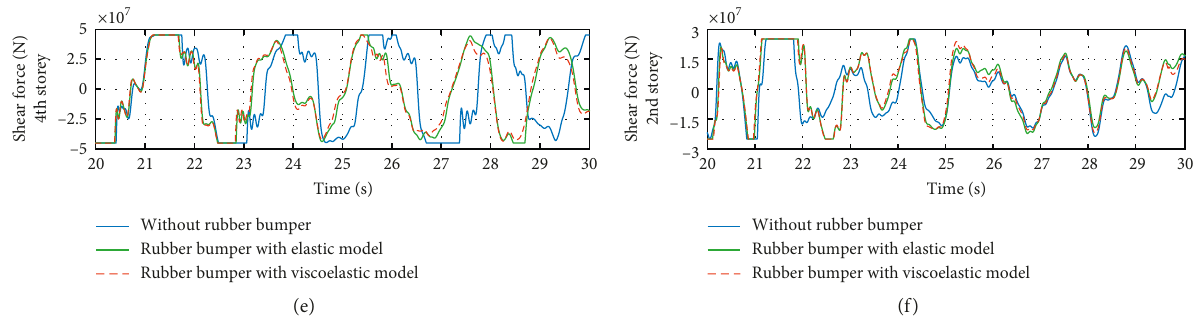
Figure 5: Shearing force time-history with three different models of collision for (a, c, e) left building storeys and (b, d, f) right building storeys.